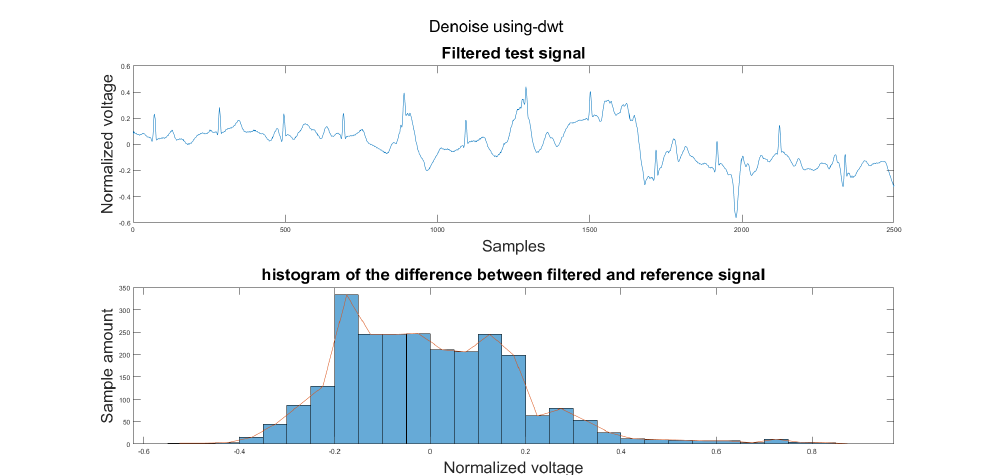
Figure A17. (1) Test signal, (2) histogram of the